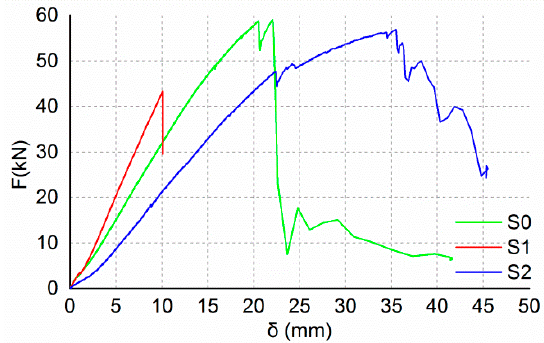
Figure 10. Load–deflection curves of shearing beams.